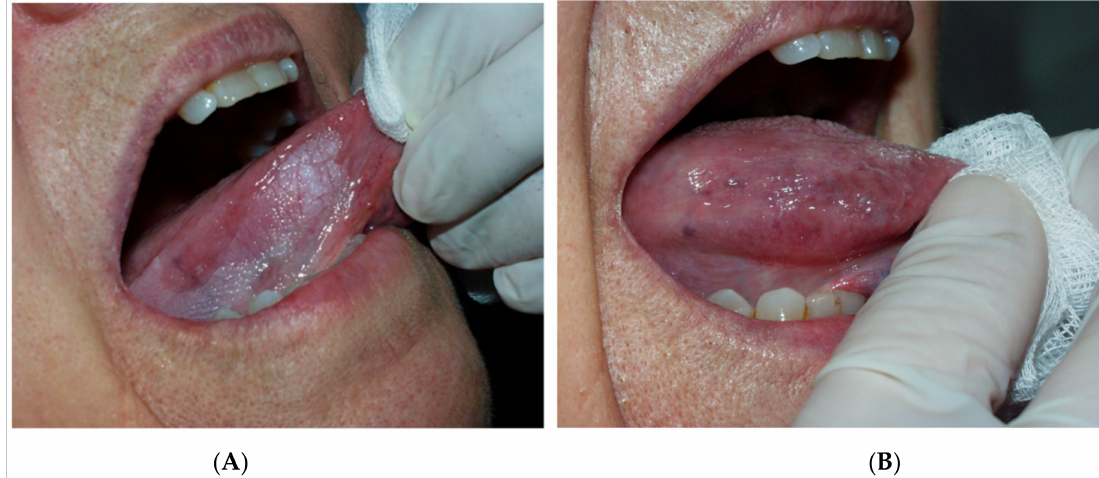
Figure 3. ( A ) before removal with CO 2 laser on lingual margin and ( B ) 3 months after treatment. Statistical analysis: The results were expressed as absolute and relative